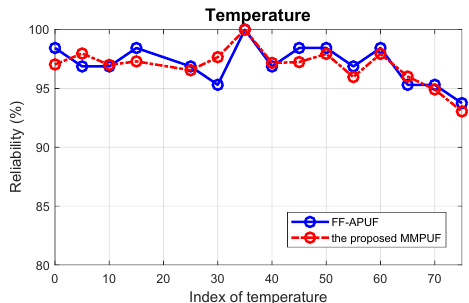
Figure 15. Reliability results considering temperature.